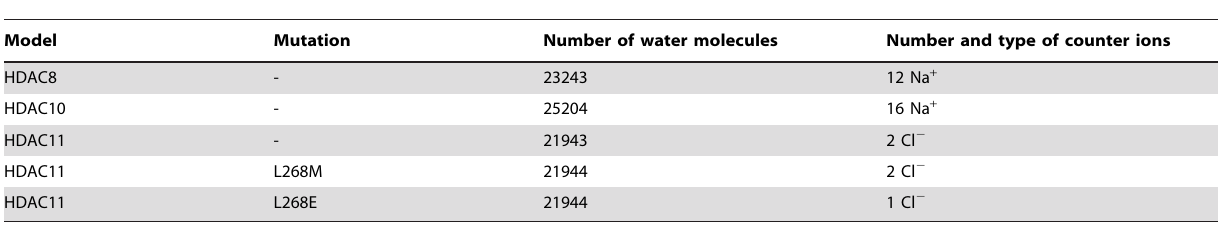
Table 3. System details of each model for MD